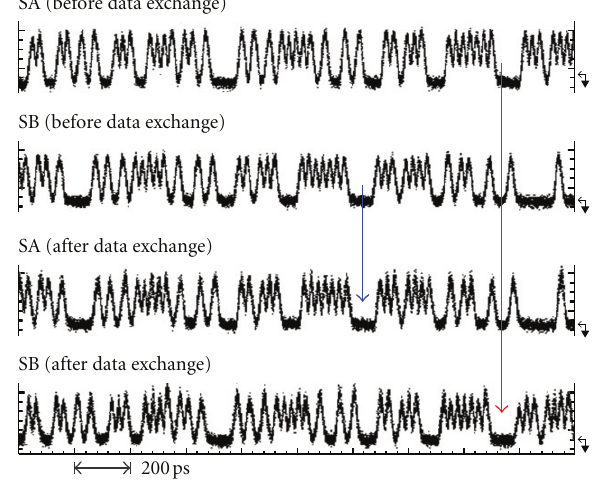
Figure 14: Measured eyes and BER performance of data exchange between two 40 Gbit/s NRZ-DPSK